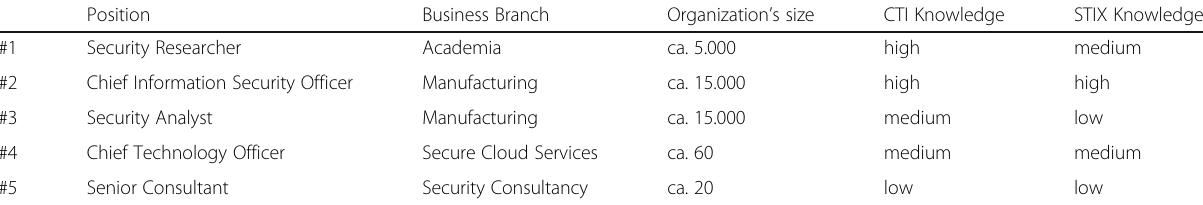
Table 2 General information on the interview